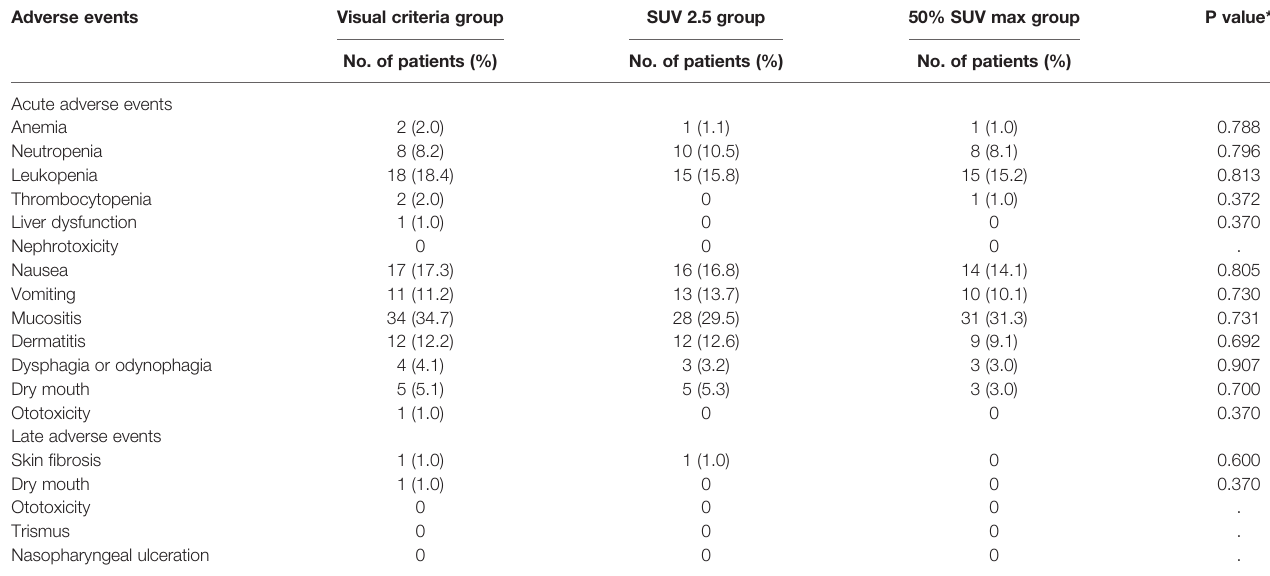
TABLE 2 | Grade 3-4